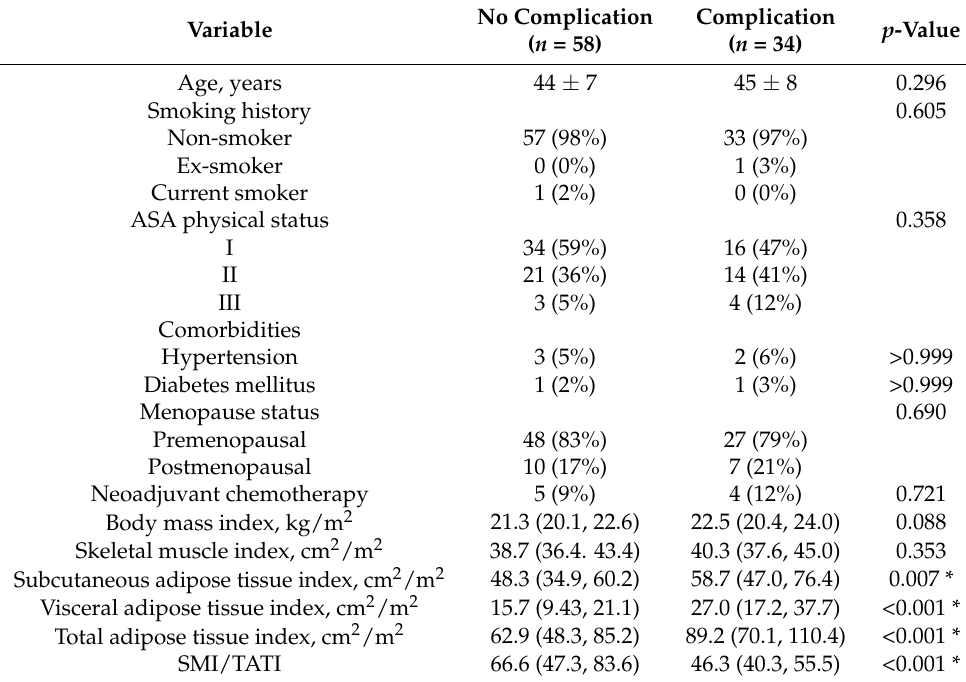
Table 1. Patient demographic and preoperative characteristics.